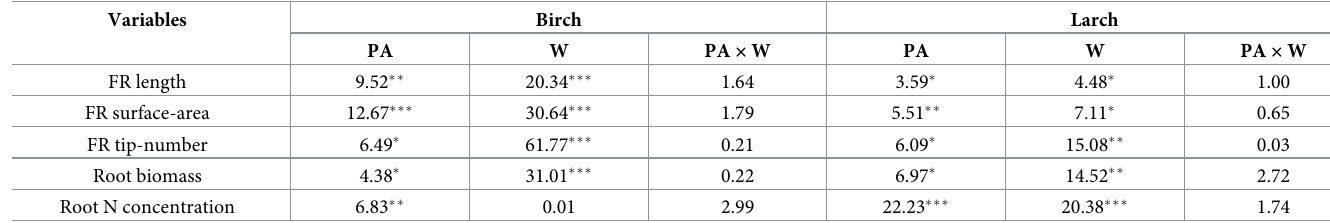
Note: FR, fine root. Asterisks indicate significance.